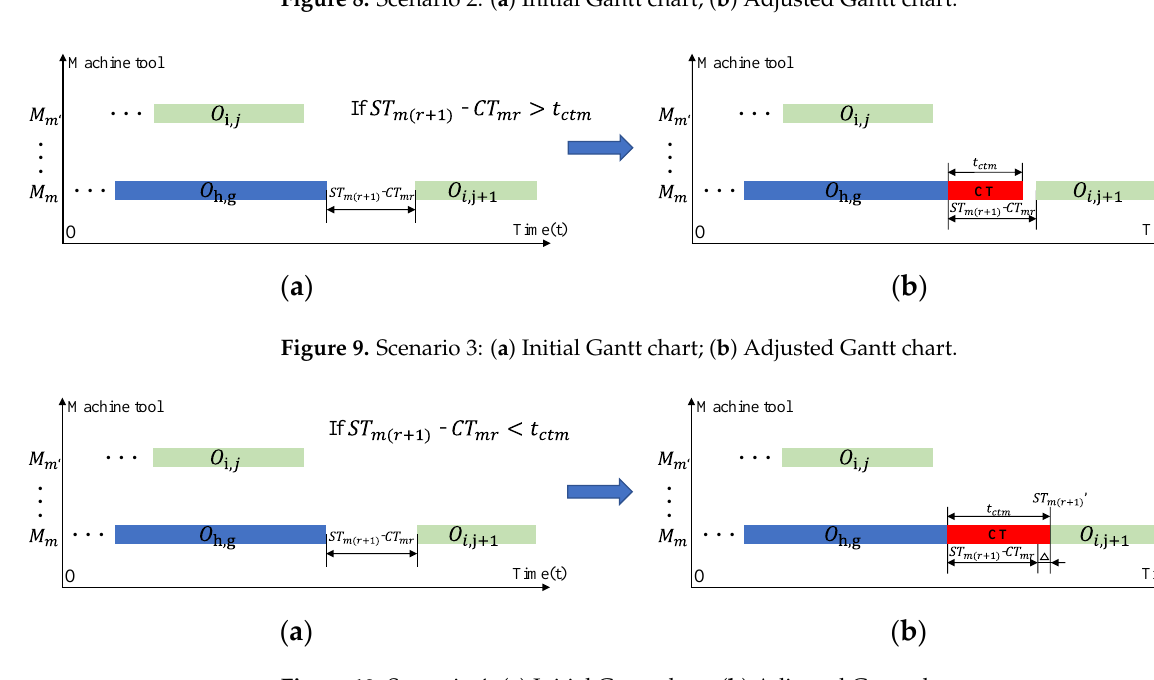
Figure 11. Scenario 5: ( a ) Initial Gantt chart; ( b ) Adjusted Gantt chart. (1) (2) ( a ) ( b ) Figure 12. Scenario 6: ( 1 ) Sufficient machine-off time; ( 2 ) Insufficient machine-off time. ( a ) Initial Gantt chart; ( b ) Adjusted Gantt chart. 4.2.3. Crossover A crossover is used to maintain population diversity and explore a new solution space. In the parent population, two types of crossover were performed according to chro- mosome types [32], with the crossover of the process chromosome occurring in odd posi- tions, while that of the machine tool chromosome occurring in even positions, as shown in Figure 13.